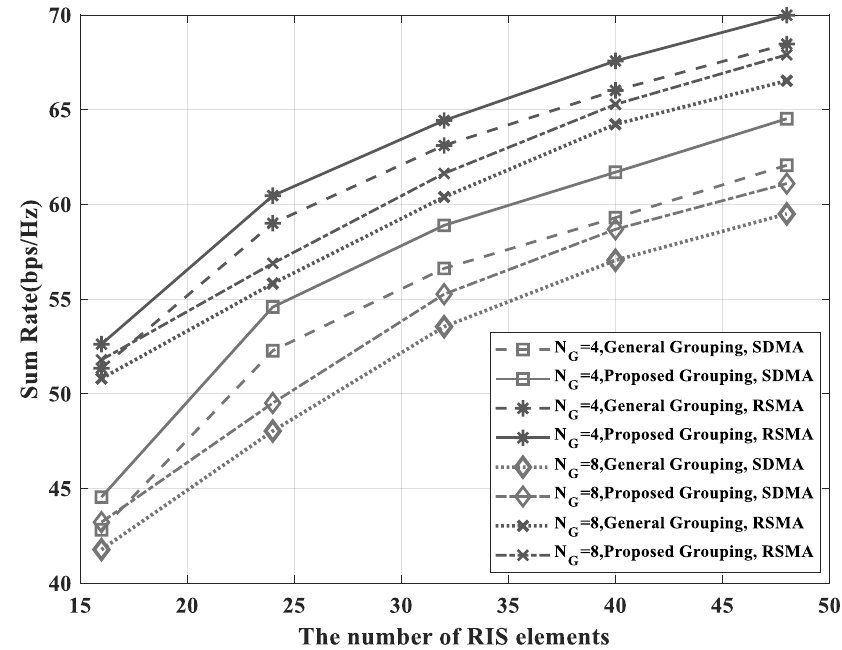
Figure 4. Sum-rate versus the number of RIS